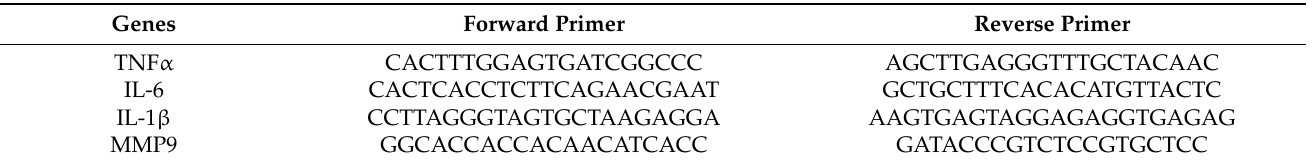
Table 1. List of